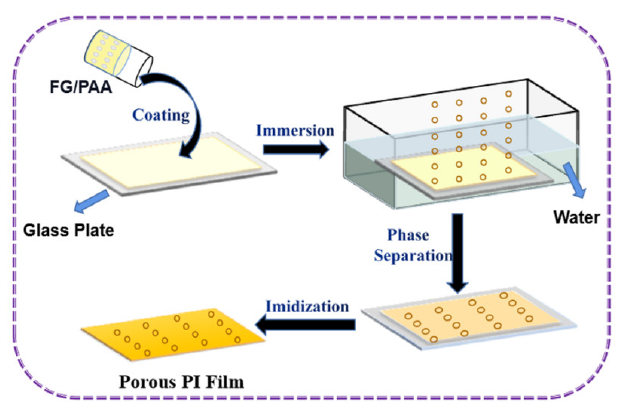
Figure 1. Schematic diagram for the formation mechanism of porous PI films.